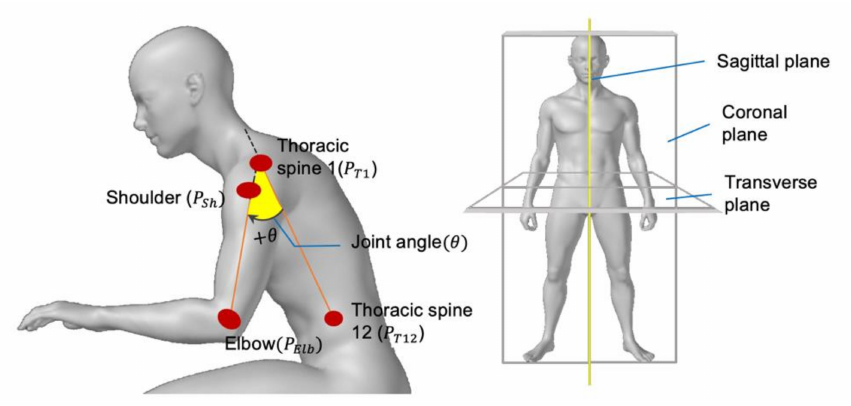
Figure 3. Body coordinates where joint angle is